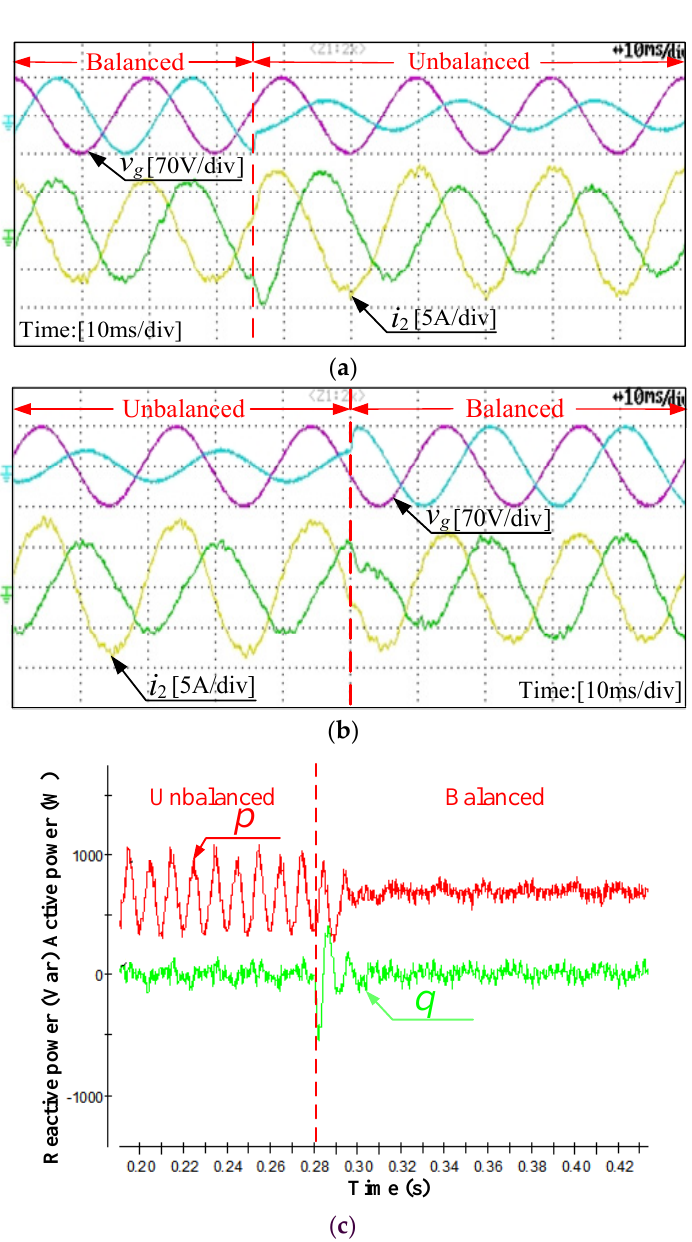
Figure 14. Experimental results of ( a ) grid-injected current when grid voltage varies from balanced to unbalanced, ( b ) grid-injected current when grid voltage varies from unbalanced to balanced, and ( c ) active and reactive power when grid voltage varies from unbalanced to balanced in case 2.